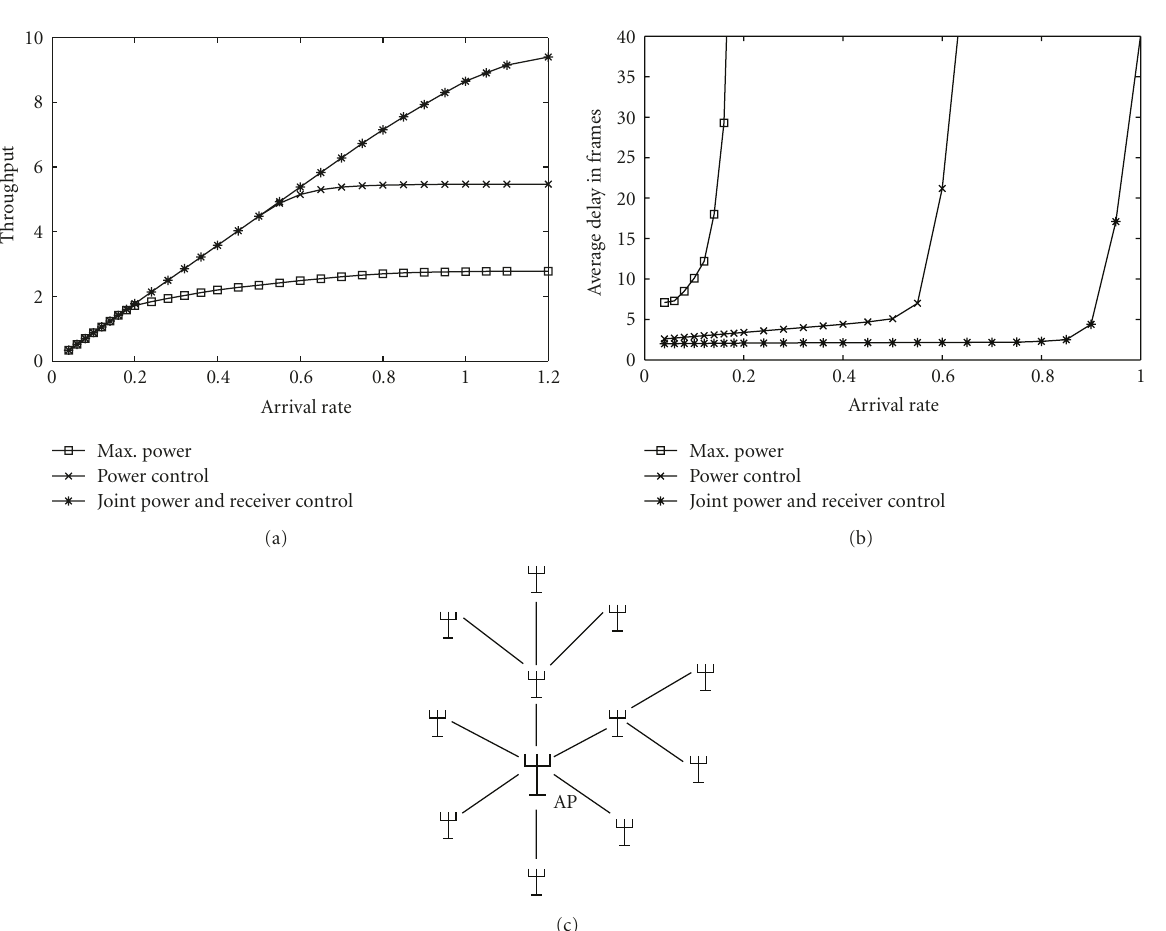
Figure 5: Throughput (a) and delay (b) performance as a function of the arrival rate for di ff erent resource allocation schemes and a given mesh network